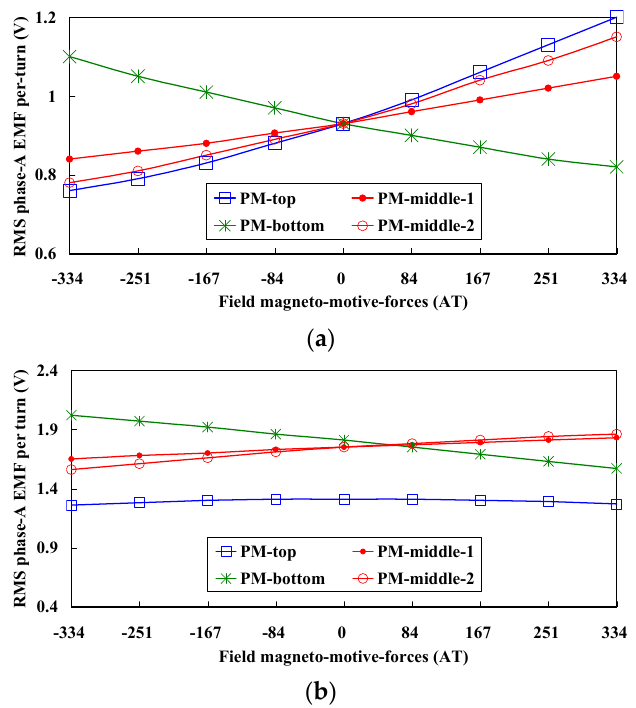
Figure 6. Variation of phase ‐ A EMF per ‐ turn by different field currents at 1500 r/min. ( a ) Employing ferrite; ( b ) Employing NdFeB.